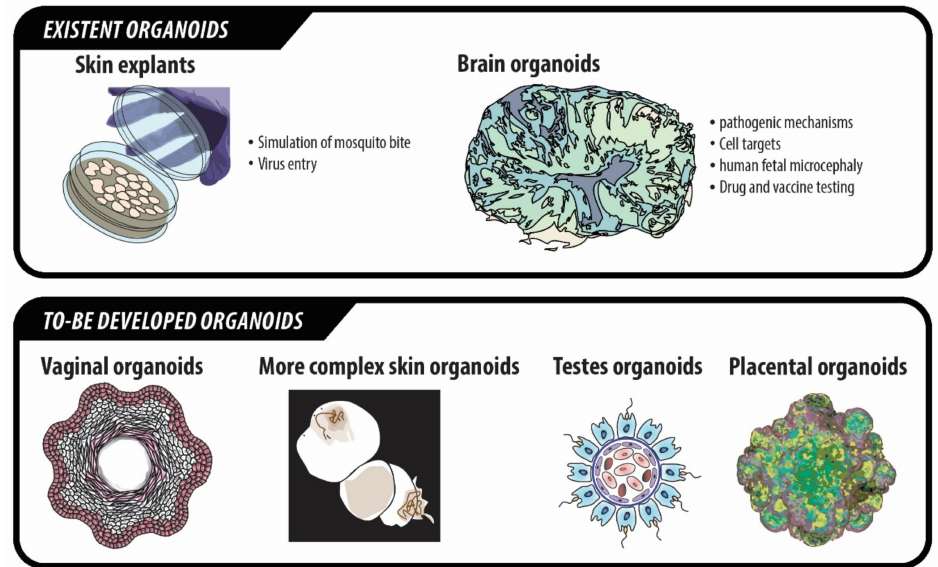
Figure 3. Organoid models used to date and potential for new to-be developed organoids for the study of ZIKV and its treatment and